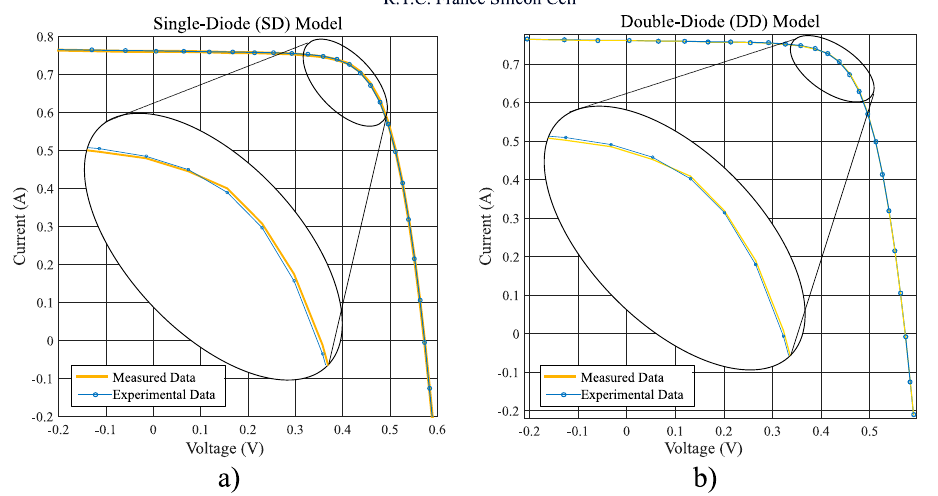
Figure 5. PV Cell’s measured and estimated I-V characteristics for ( a ) SD model and ( b ) DD model under specific test conditions ( G = 1000 W/m 2 and T c = 33 ◦ C ).